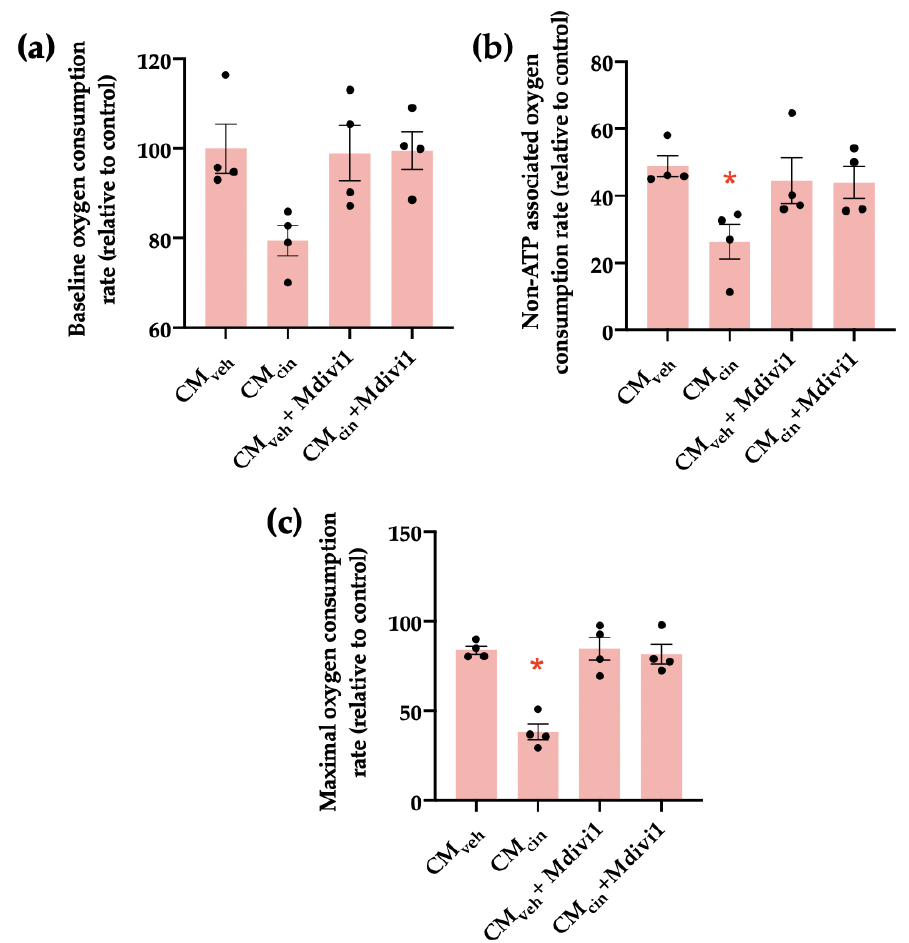
Figure 9. Mdivi1 inhibits the mitochondrial bioenergetics alterations induced by CM cin on HepG2 cells: ( a ) quantification of baseline oxygen consumption rates of HepG2 cells treated with CM veh or CM cin and subsequently treated or not with Mdivi-1; ( b ) quantification of non-ATP-associated oxygen consumption rates of treated HepG2 cells; ( c ) quantification of maximal capacity oxygen consumption rates of treated HepG2 cells. Each dot represents an individual experiment ( n = 4). * p < 0.05 versus the control, Friedman’s test, and Dunn’s post-hoc test.